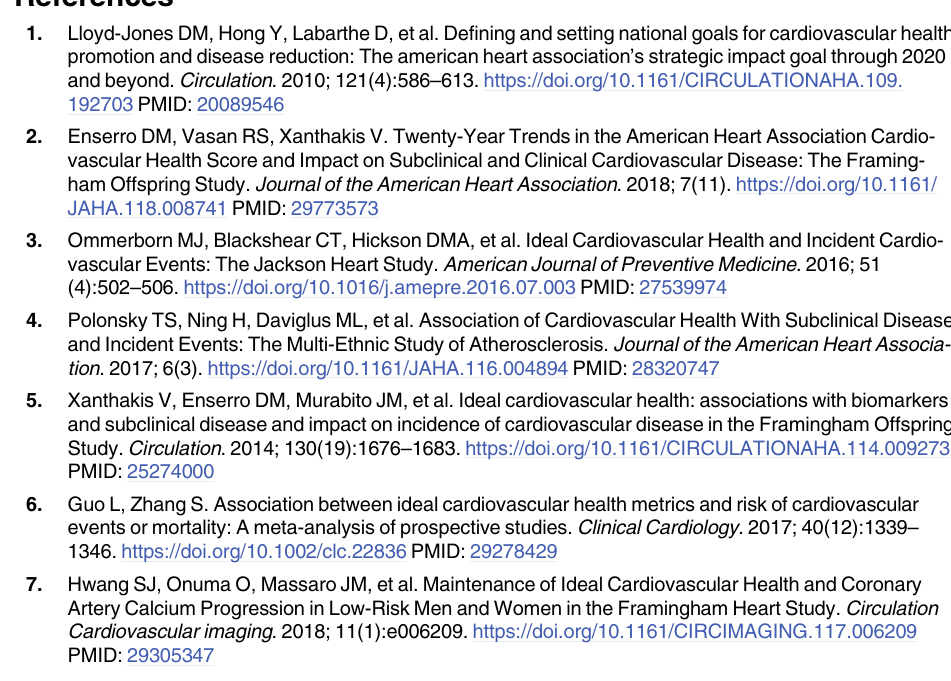
S4 Table. Pooled frequencies and percentages of incident CVD with present SubDz (FOS and Gen3). S1 Fig. Flow diagram of study sample in the Framingham Offspring cohort. S2 Fig. Flow diagram of study sample in the Framingham Third Generation cohort. S3 Fig. CVH-SubDz-CVD Paradox by A) sex and B) age groups (median